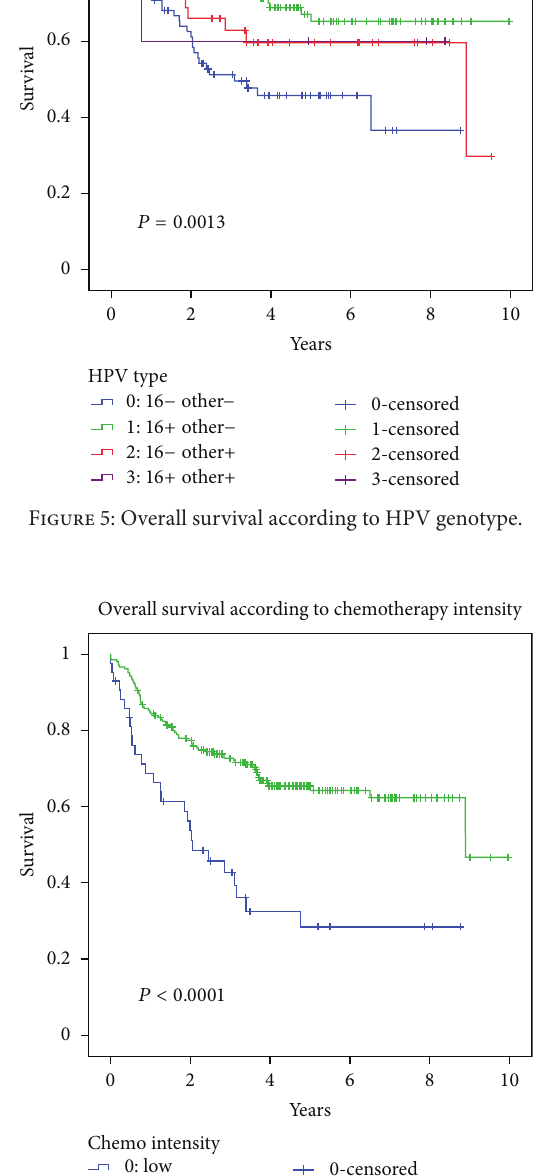
DFS was also 8.89 years for patients receiving high-dose chemotherapy and 1.63 years for patients receiving low-dose chemotherapy (𝑃 = 0.0001) . Median LRC was 8.89 years and 1.92 years for patients receiving high- and low-dose chemotherapy, respectively (𝑃 < 0.0001)